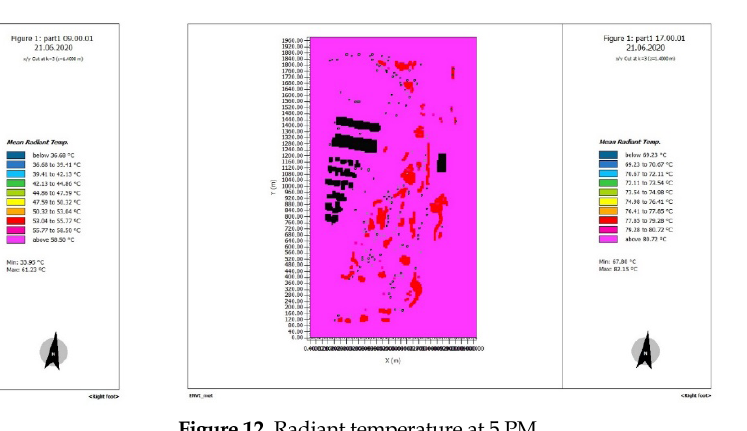
Figure 11. Radiant temperature at 9 AM Figure 12. Radiant temperature at 5 PM